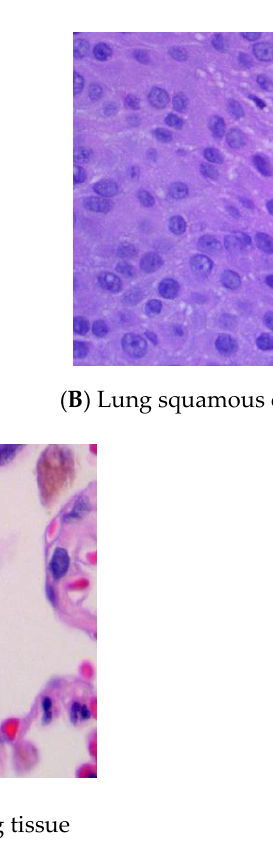
Figure 2. Representative histopathological images of ( A ) lung adenocarcinoma, ( B ) lung squamous cell carcinoma and ( C ) benign lung tissue. cell carcinoma and ( C ) benign lung